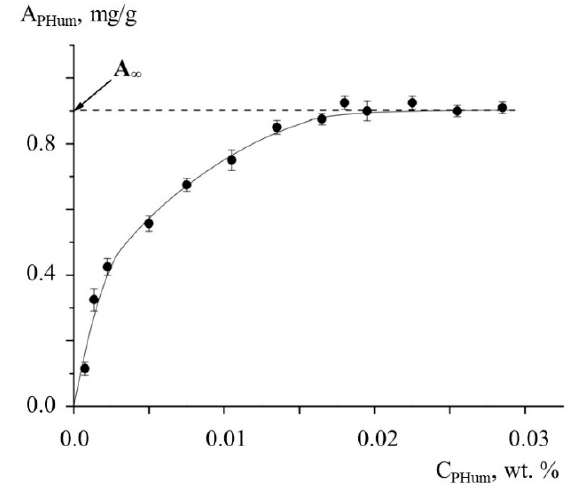
Figure 1. The dependences of the kaolinite-bound PHum, A PHum , on the concentration of aqueous PHum solutions, C PHum . 4 wt.% kaolinite aqueous suspension, pH = 6.5.